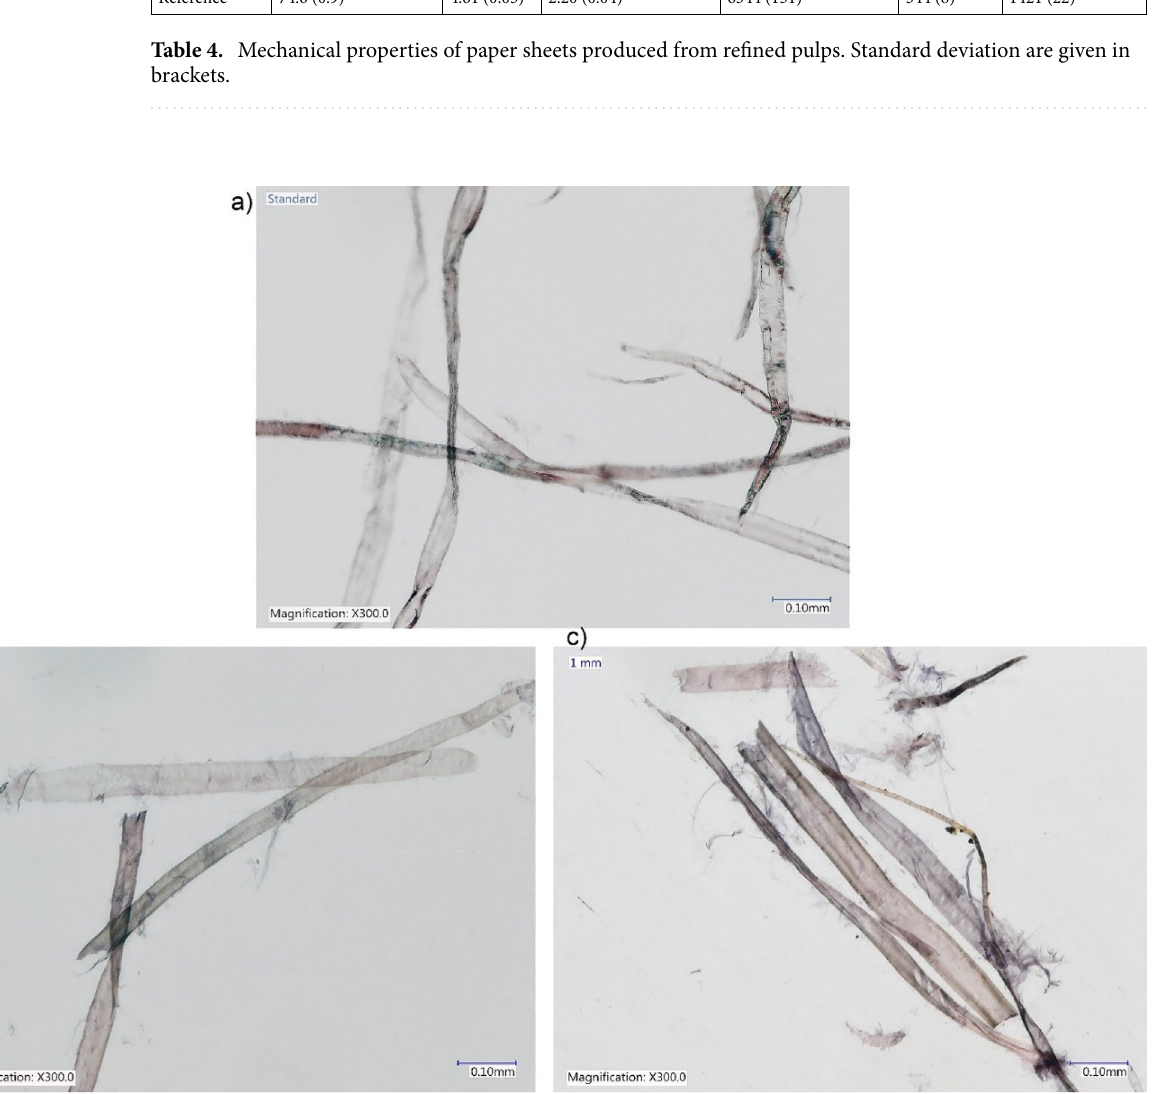
Figure 3. Microscopic images of paper sheets derived from ( a ) reference and ( b , c ) selected refined pulps produced from the tested fibrous